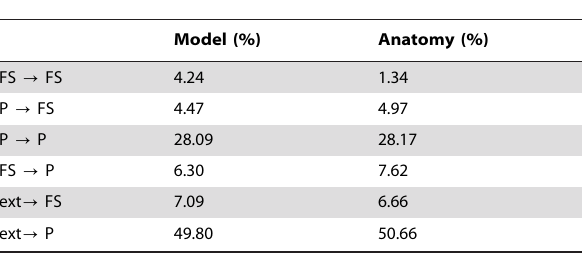
Table 1. Model connectivity